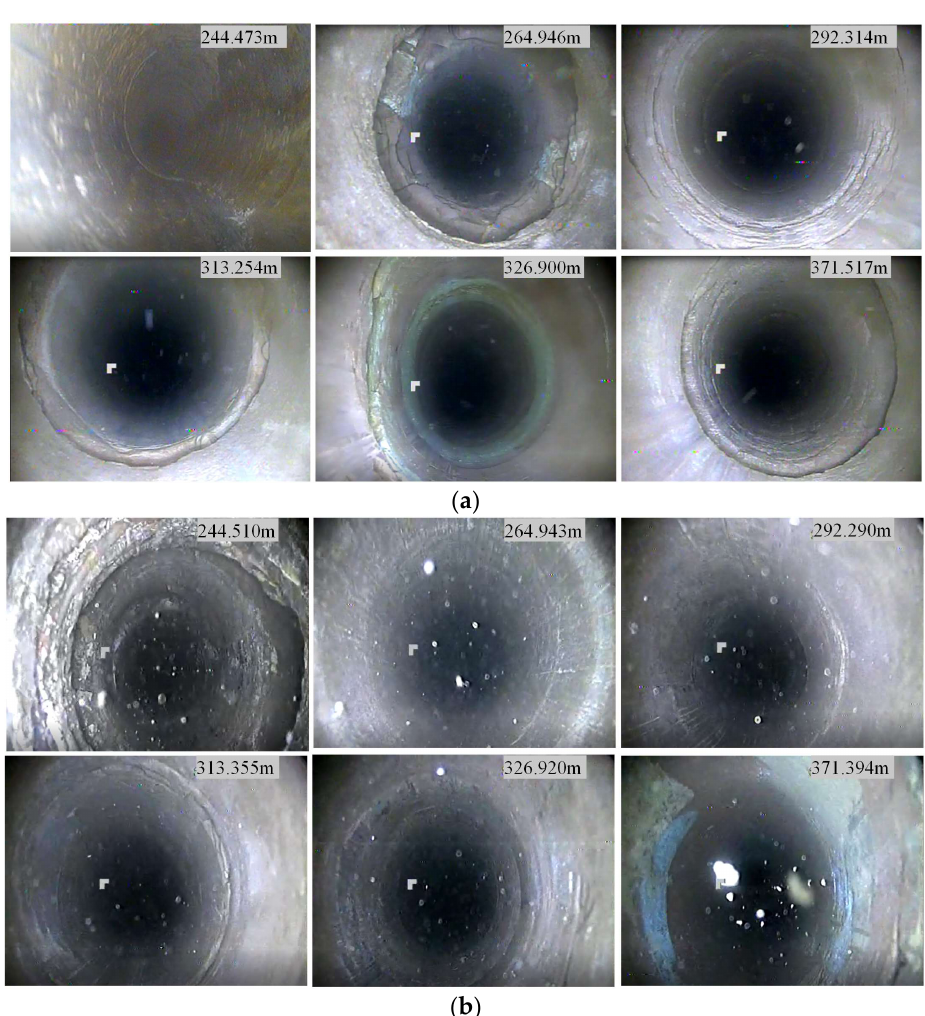
Figure 11. Distribution of fractures in the boreholes: ( a ) No.Y1-1 borehole and ( b ) No.Y4 borehole. Based on the internal cracks of Y1-1 (Figure 11a), before Working Face #207 was